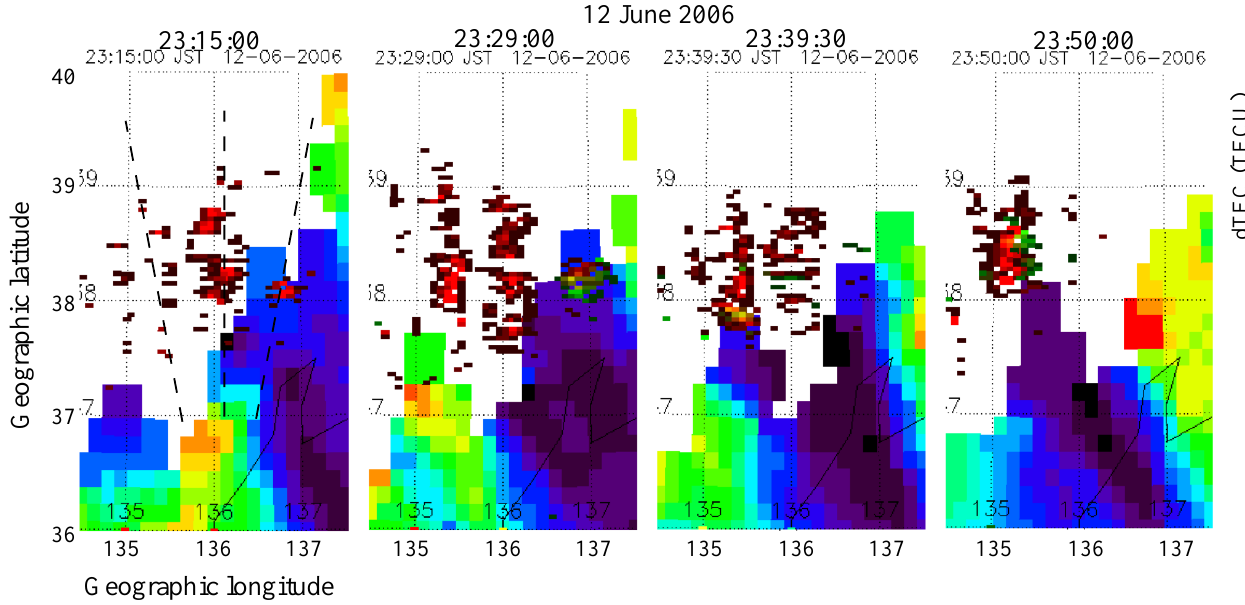
Fig. 9. Sequential images of echoes from beam 1, 2, and 3 together with TEC perturbation observed from 23:15 to 23:50JST on 12 July 2006. The images are projected on a horizontal plane at an altitude of 300km along the geomagnetic field line. Dashed lines in the images show the center of the radar beams.